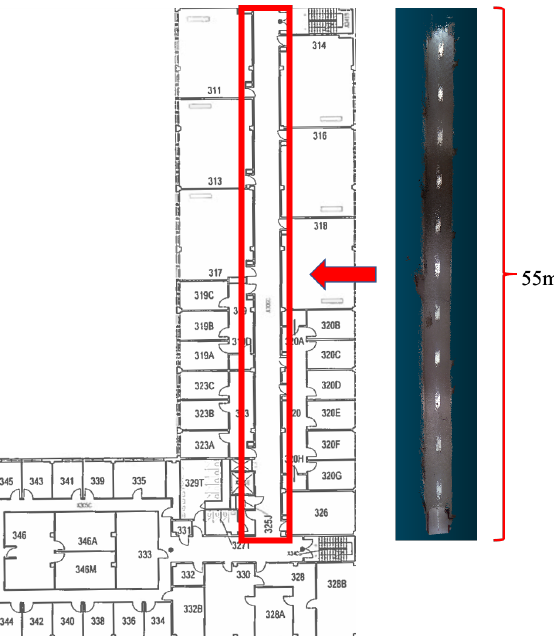
Figure 3. Experiment environment (left) and top view of 3D model rendered from RTAB-map (right).